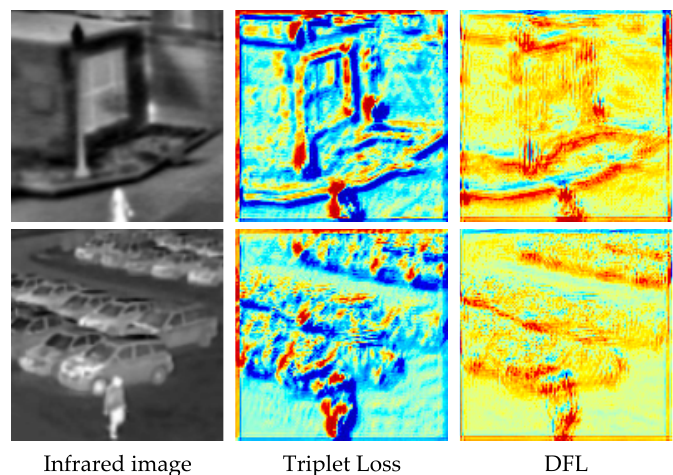
Figure 11. Ablation experiments on the effectiveness of our feature refinement block. Column 1 is the infrared image of the input to our network. Column 2 is a visualization of the attention maps in the “Feature extraction block & Feature integration block” framework. Column 3 is a visualization of the attention map in the “Backshift mask predictor” framework. Column 4 is a visualization of the attention map in the “Triplet Loss” [40] framework.